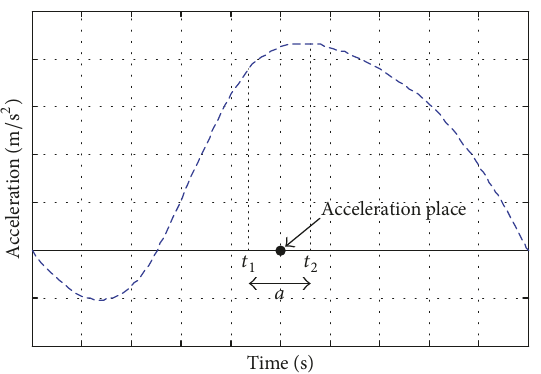
Figure 12: Schematic of calculating a representative scalar value for an accelerometer. 𝑎 = the domain of data from 𝑡 1 to 𝑡 2 .